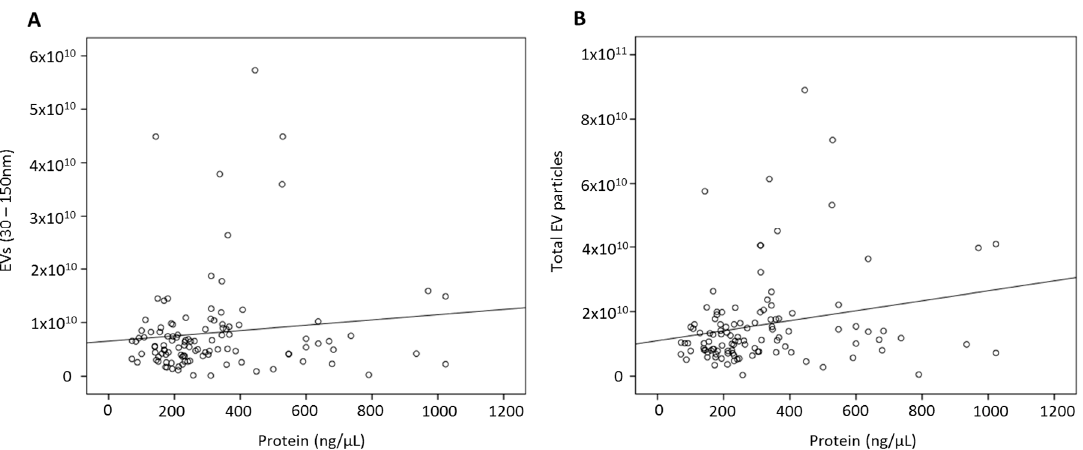
Figure 2. Investigation of relationship between protein yield and number of EV particles quantified by NTA: No relationship was detected between ( A ) protein yield and small EV particles (30–150 nm, rho = 0.092, p = 0.339) with only a mild correlation between protein yield and total number of EV particles ( B ) detected (rho = 0.216, p = 0.027) in human serum samples.